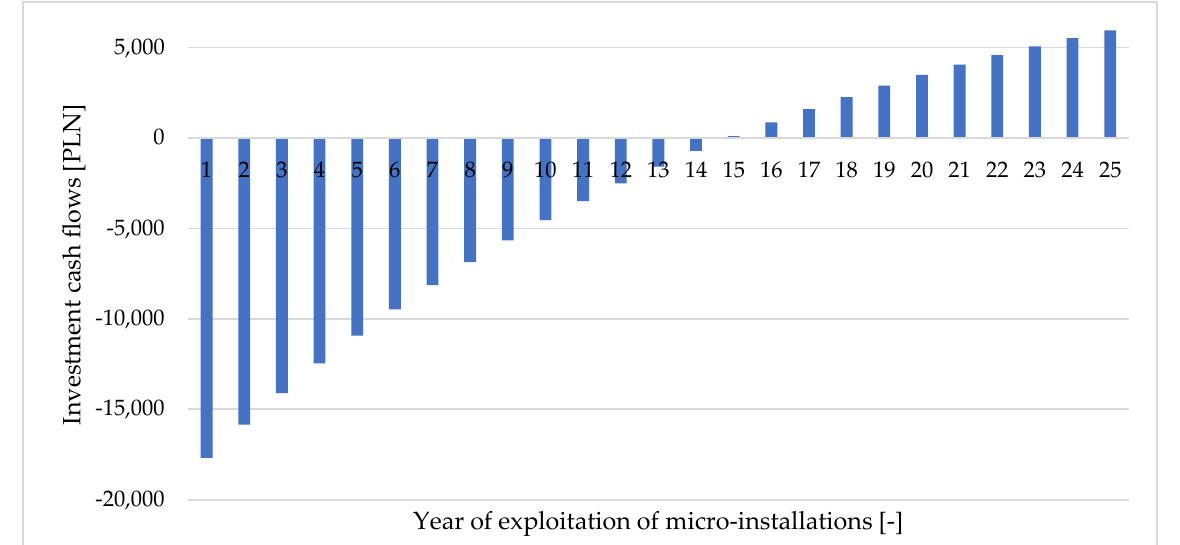
Figure 14. Graph showing the investment cash flow as a function of time of operation for the net- billing system based on monthly prices and a 60% self-consumption level.